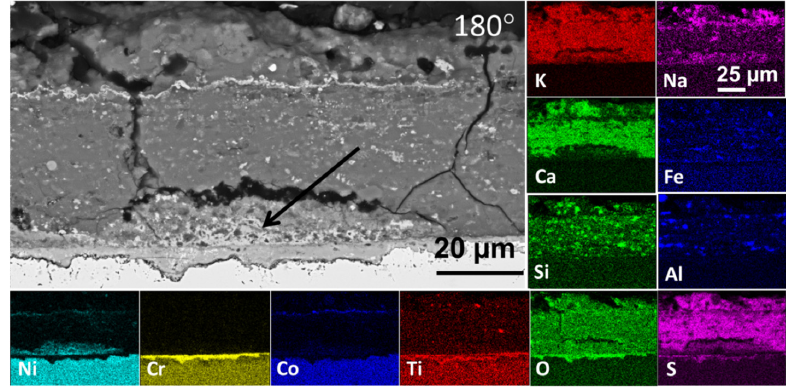
Figure 8. SEM (BSE) image of the metal surface of A263 nickel alloy and EDX map analysis from the leeward side. The arrow pointing to the porous oxide scale containing zinc. leeward side. The arrow pointing to the porous oxide scale containing zinc.